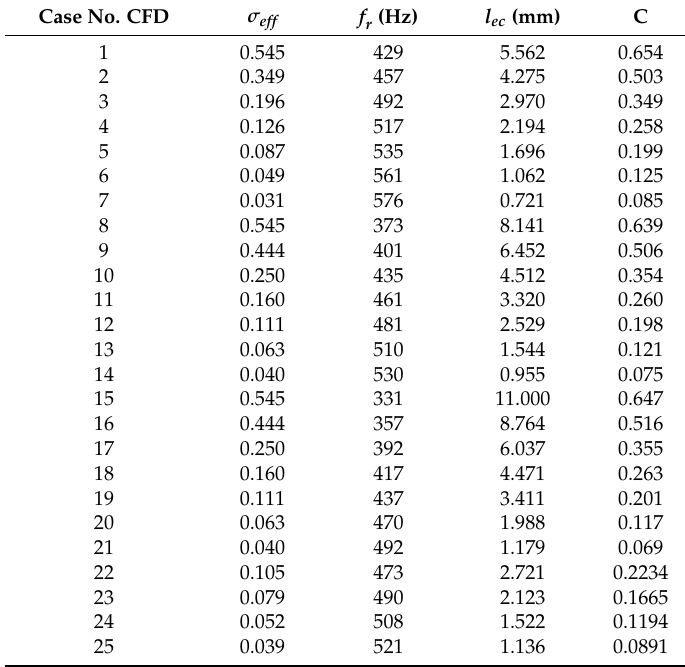
Table 3. Numerical results of resonance frequencies and end correction lengths for all simulated perforated